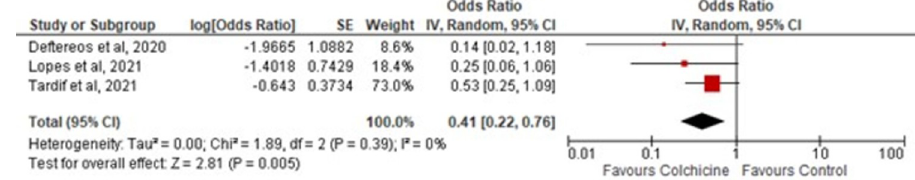
Fig 2. Association of COVID-19 severity in colchicine users. Red squares and their corresponding lines are the point estimates and 95% confidence intervals per each study. Black diamonds represent the pooled effect estimate.